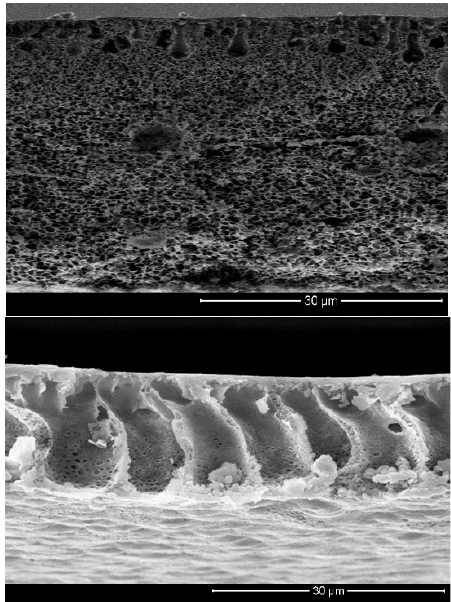
Figure 6. SEM images of MWCNTs/PPy nanocomposite: ( a ) PPC-0.3, ( b ) PPC-0.05. Cross-sectional and membrane surface images of pristine, PP, PPC-0.05 and PPC-0.3